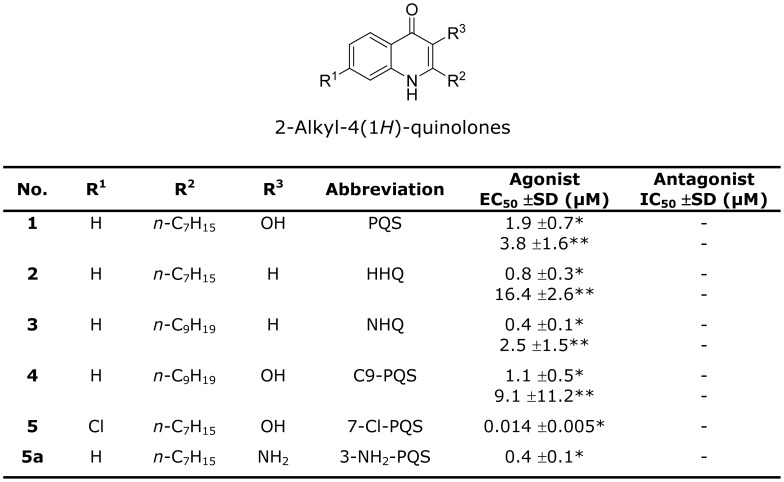
Activation and inhibition of PqsR in P. aeruginosa by the 2-alkyl-4(1H)-quinolones.*EC50 determined in a P. aeruginosa ΔpqsA CTX::pqsA'-lux strain; **EC50 determined in a P. aeruginosa ΔpqsAH CTX::pqsA'-lux strain; – no activity.